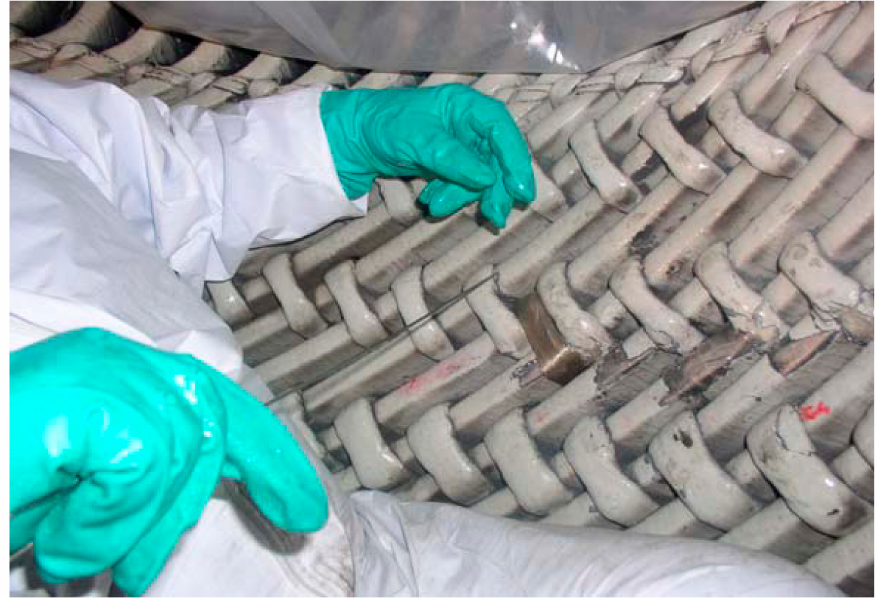
Figure 2. Restating ties with glass roving and